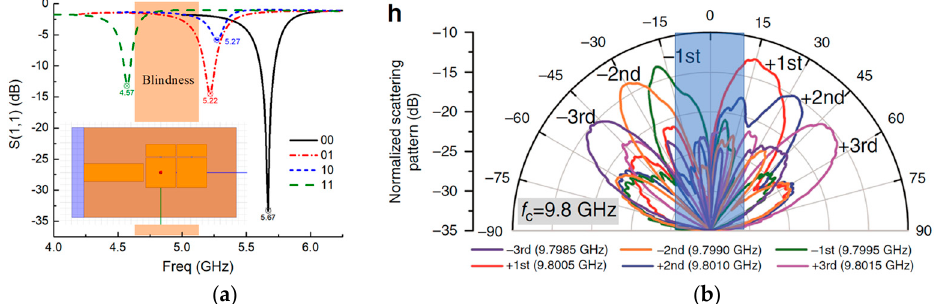
Figure 1. Tuning blindness exists in ( a ) a compact MTM antenna with two periodical units and in ( b ) programmable spatial radiation patterns [9].